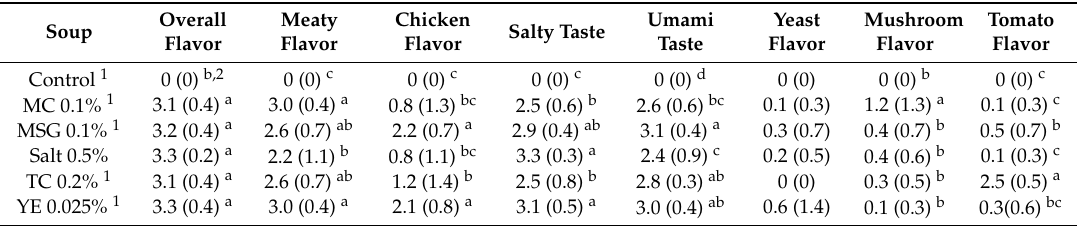
Table 3. The degree-of-difference-from-control (DODC) mean intensity scores (standard deviation in parentheses) of chicken soup samples on a 10-point intensity